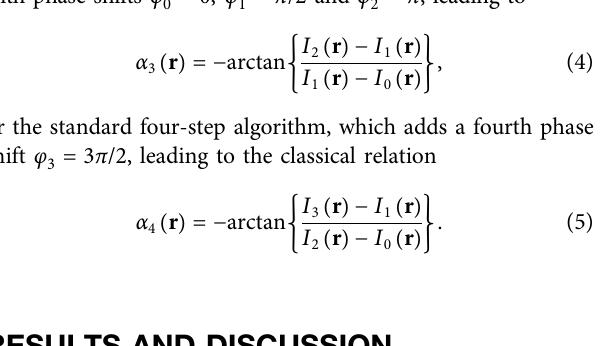
FIGURE 2 | Illustration of the complex encoding technique. LG 13 mode (A) intensity [ M ( r )] 2 and (B) phase θ ( r ) distributions. (C) Phase-only function ϕ ( r ) encoding the complex function with the checkerboard grating H technique. (D) Phase function ϕ ( r ) (cid:1) ϕ H ( r ) + ϕ L ( r ) when a lens is